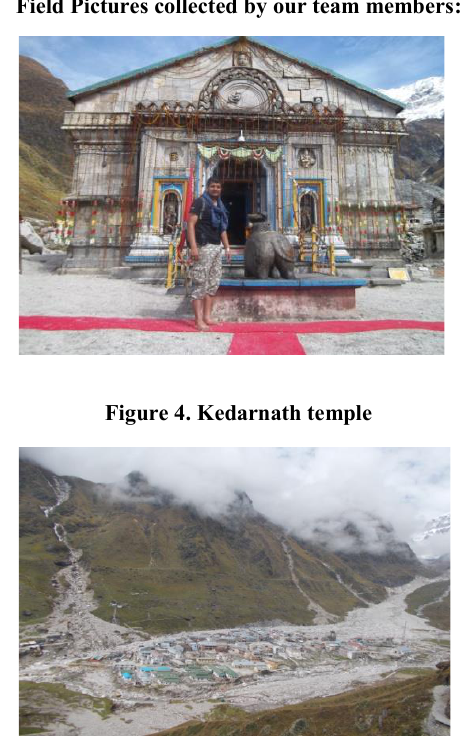
Figure 5. Aerial photo of 20th June,